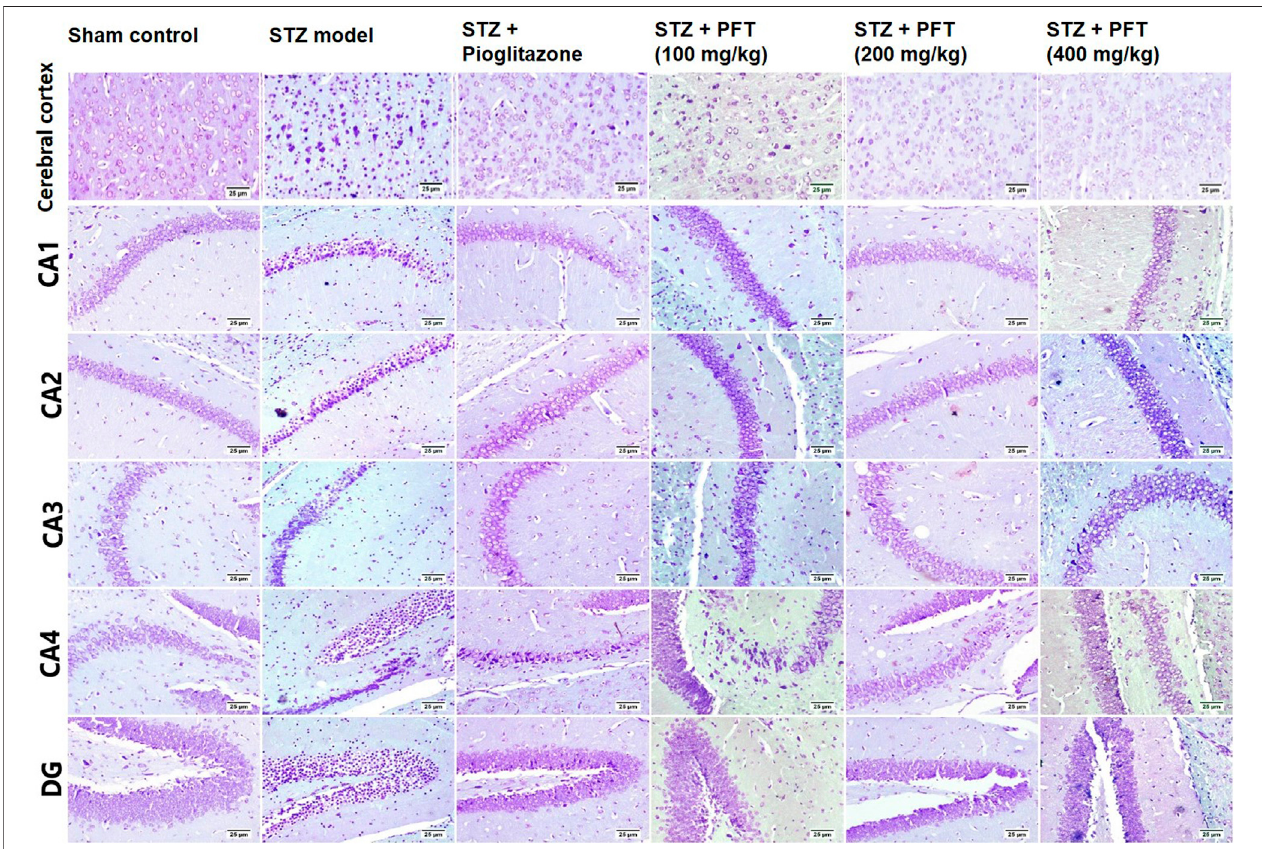
FIGURE 8| Nissl stainingof the cerebral cortex, and the hippocampal regions (CA1, CA2, CA3, CA4 and DG) sections. Sham control group showed normal intact neurons in the cerebral cortex and in all the hippocampus region. Variable number of shrunken neurons with pyknotic nuclei was detected among different treated groups with evidence of increase in STZ